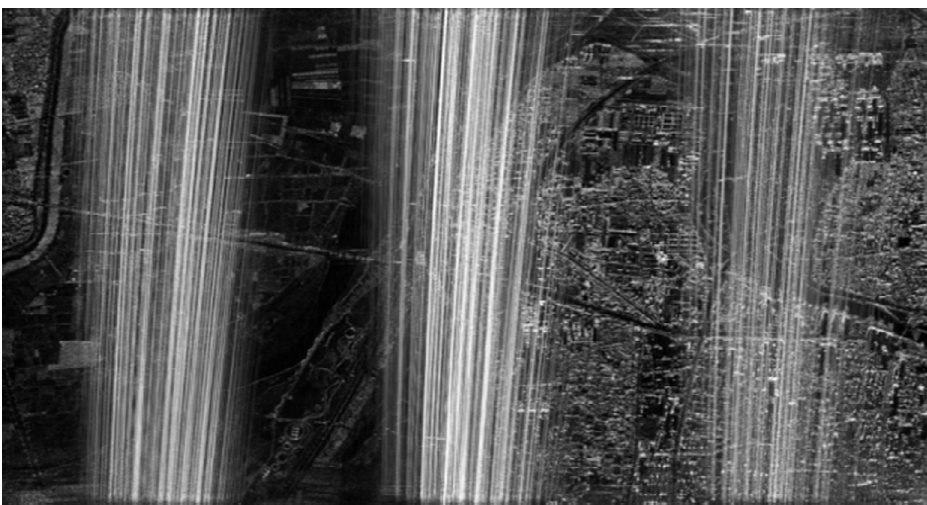
Figure 15. SAR image without jamming.